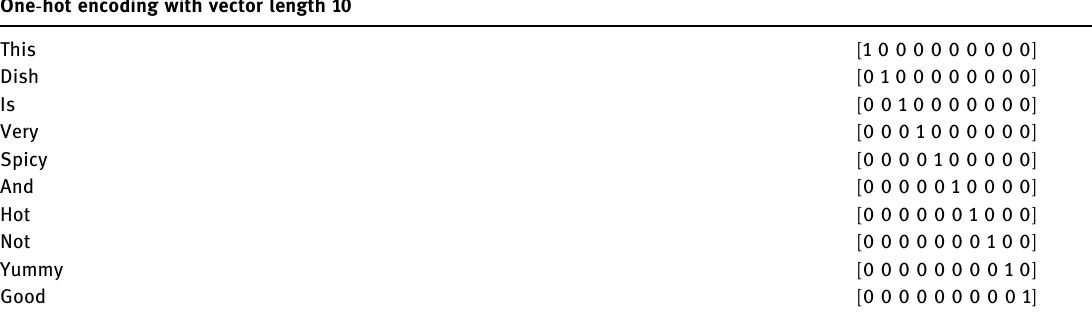
Table 2: Word2Vec one - hot encoding One - hot encoding with vector length